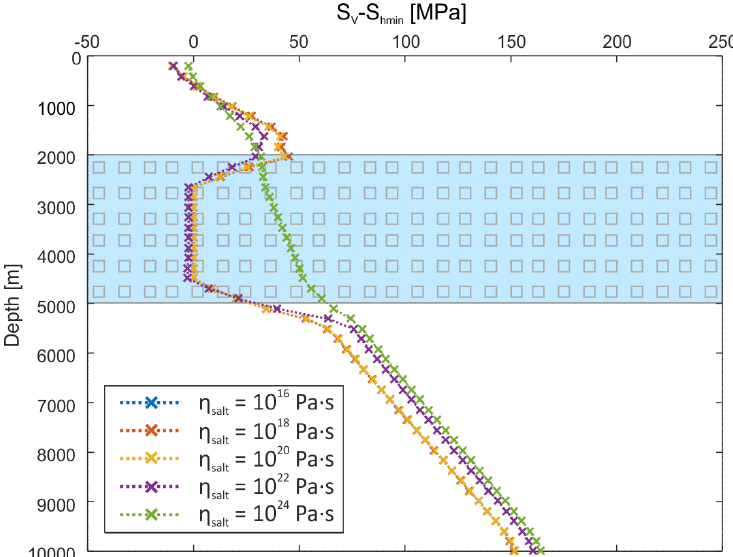
Figure 9 . Stress difference S V -S hmin for five different salt viscosities ranging from 10 16 to 10 24 Pa·s. Stresses are plotted along a vertical well path through the centre of the salt diapir (see W1 in Figure 2c) for Models B-01, B-04c, B-06, B-08 and B-09. S V -S hmin of Model B-01 (10 16 Pa·s) is hard to see as it is almost identical to Model B-04c (10 18 Pa·s). The blue layer marks the depth interval covered by the salt diapir.